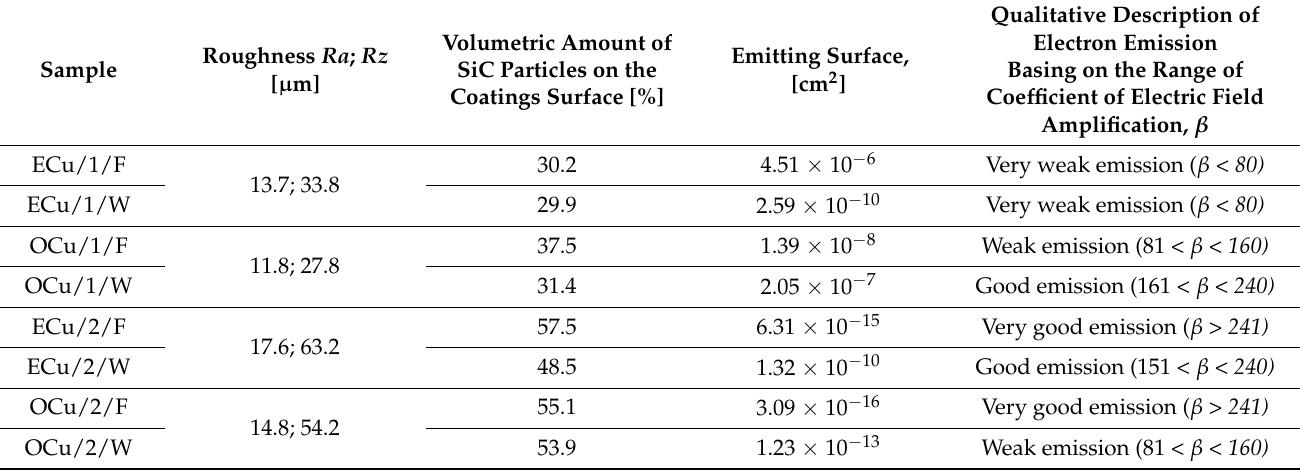
Table 3. Composite coatings